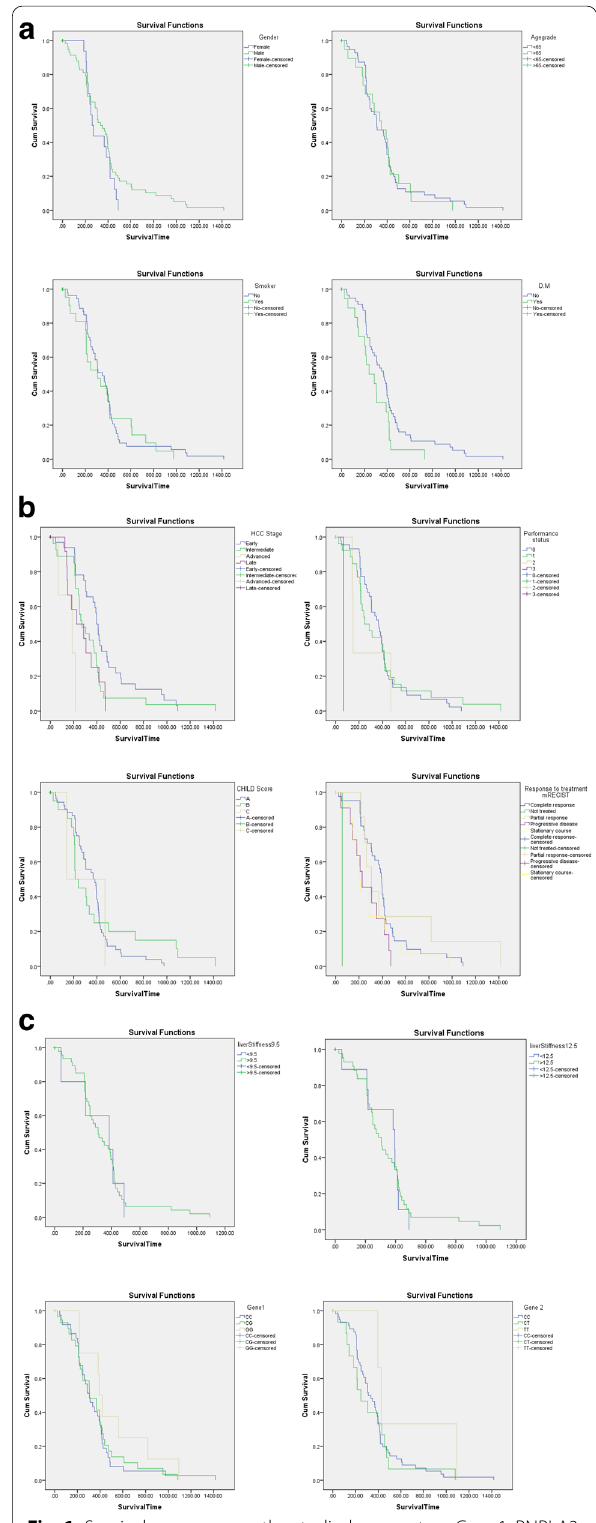
Fig. 1 Survival curve among the studied parameters; Gene1: PNPLA3, gene 2: